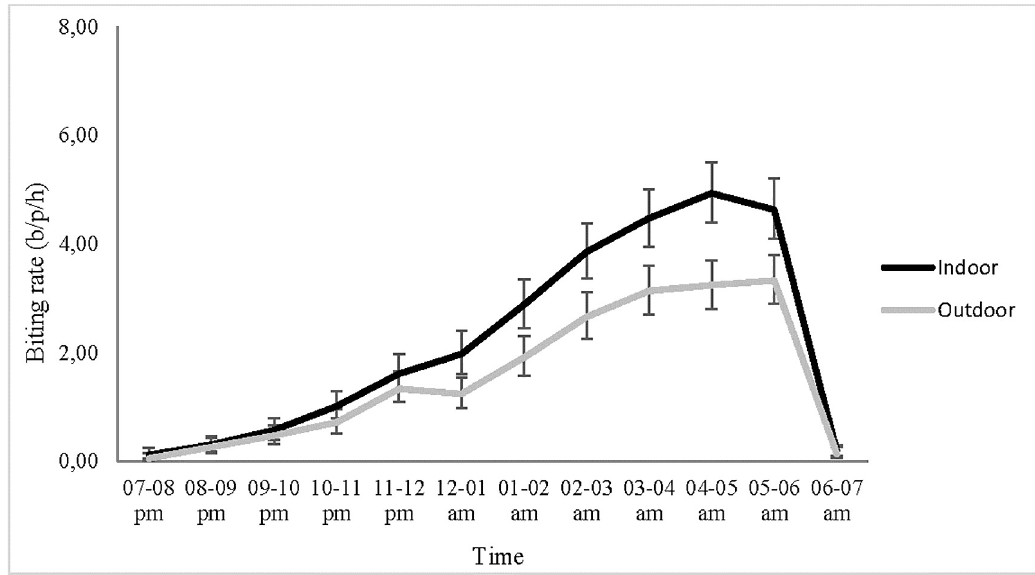
Fig 3. An . gambiae s.l. hourly biting rates in the study area (N = 6373 indoors, N = 4434 outdoors), b/p/h: Bite/person/hour, the error bars indicate the confidence intervals.